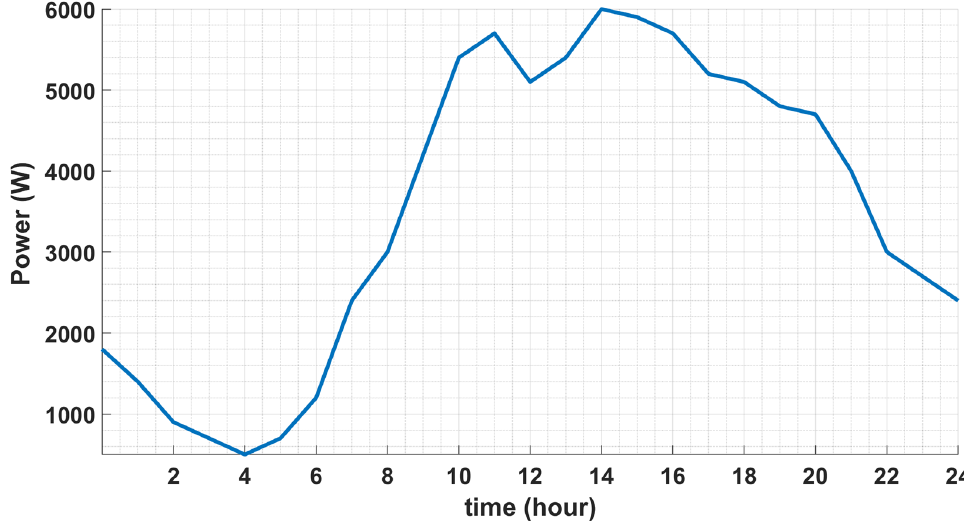
13 of 21 Figure 8. Total PVs output pattern.